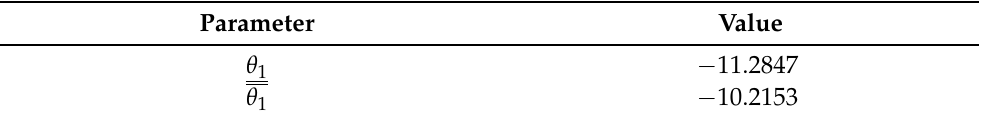
Table 1. Link embedded parameter max. and min. value.